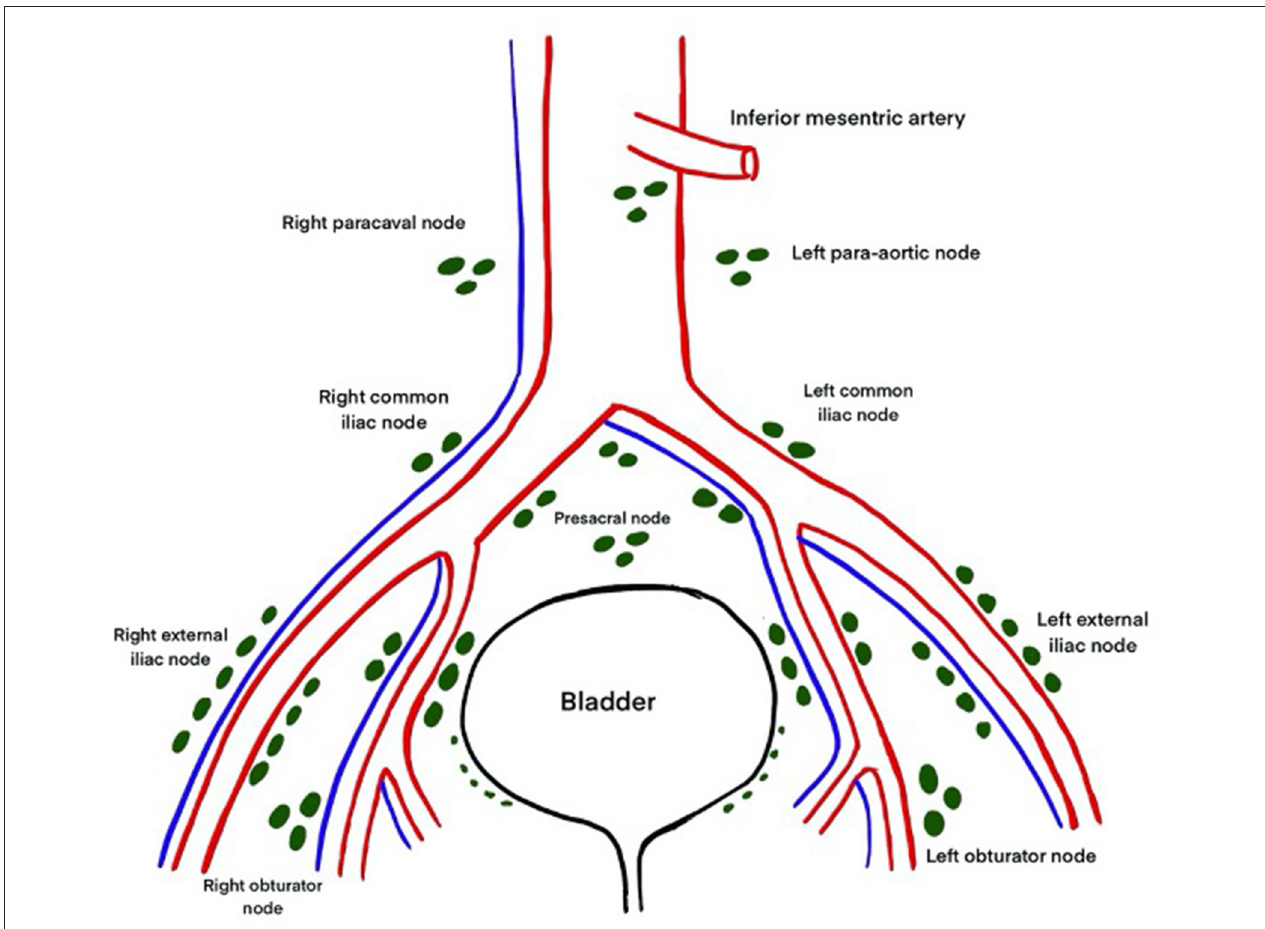
FIGURE 2 | Anatomy of lymphatic drainage of the